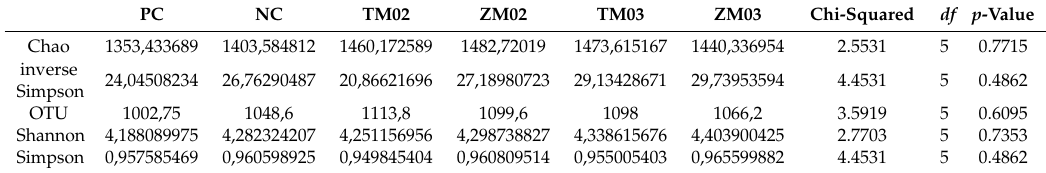
Table 2. Results of alpha diversity comparison among groups by Kruskal–Walls